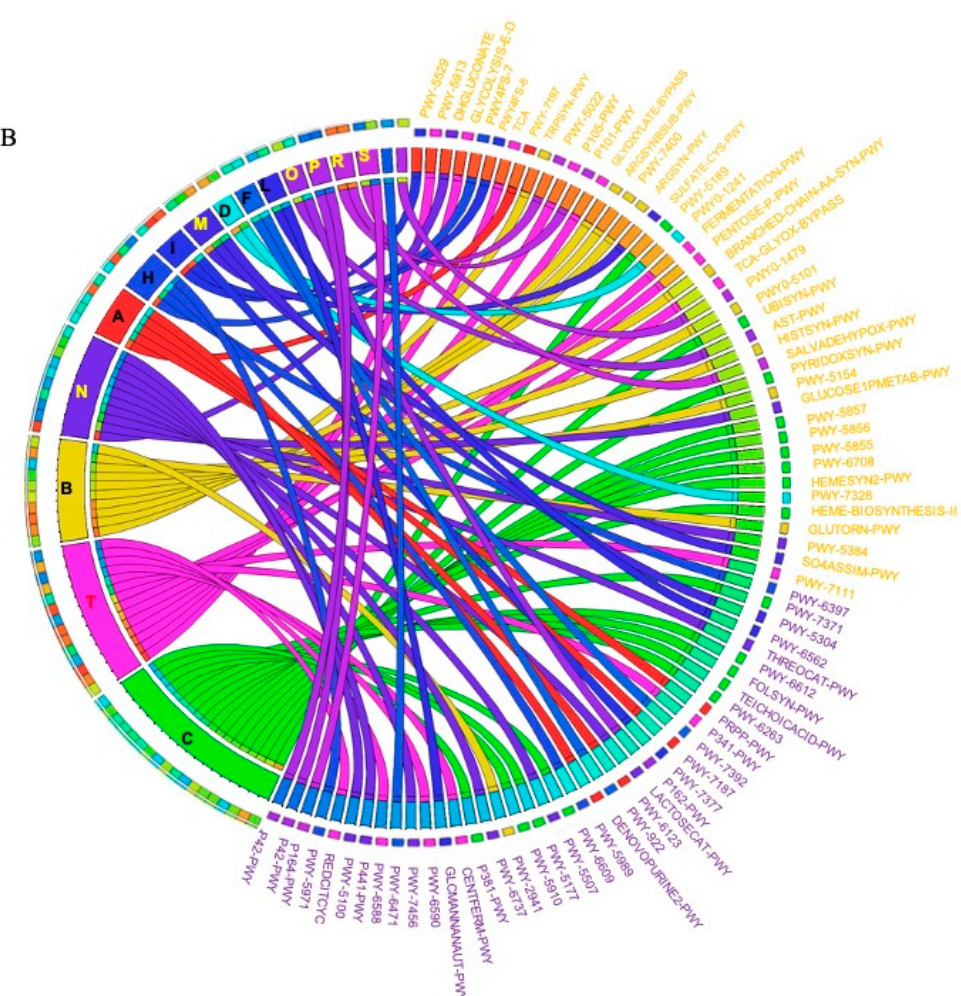
Figure 4. ( A ) LEfSe identified the most differentially abundant PICRUSt-predicted KEGG pathways between ADC and SRCC. SRCC-enriched pathways are indicated with a negative LDA score (purple) and pathways enriched in ADC with a positive score (orange). Only pathways meeting an LDA significant threshold of > 2 are shown. ( B ) Circos plot was generated to achieve insights into the relevant super-classes to which pathways belong.